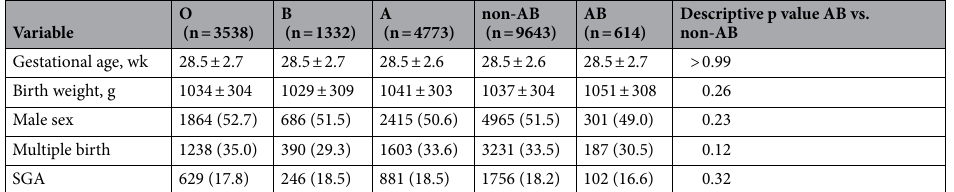
Table 1. Baseline characteristics of the study population, stratified by ABO blood group. Values are mean with corresponding standard deviation or n (%); SGA small for gestational age, NEC necrotizing enterocolitis, FIP focal intestinal perforation; *For continuous variables Mann–Whitney-U test and for binary variables χ 2 test was used.